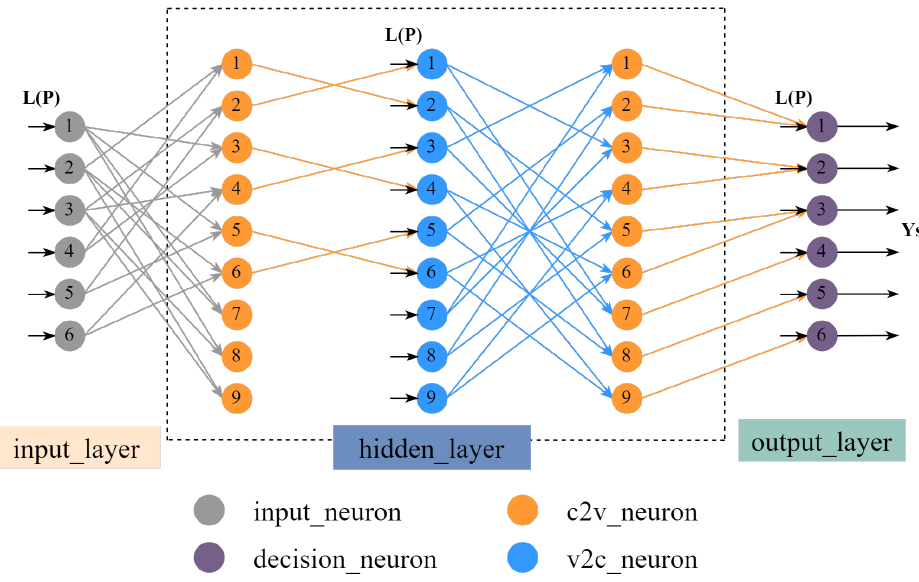
Figure 5. The network structure of (9) with 3 hidden layers corresponds to 2